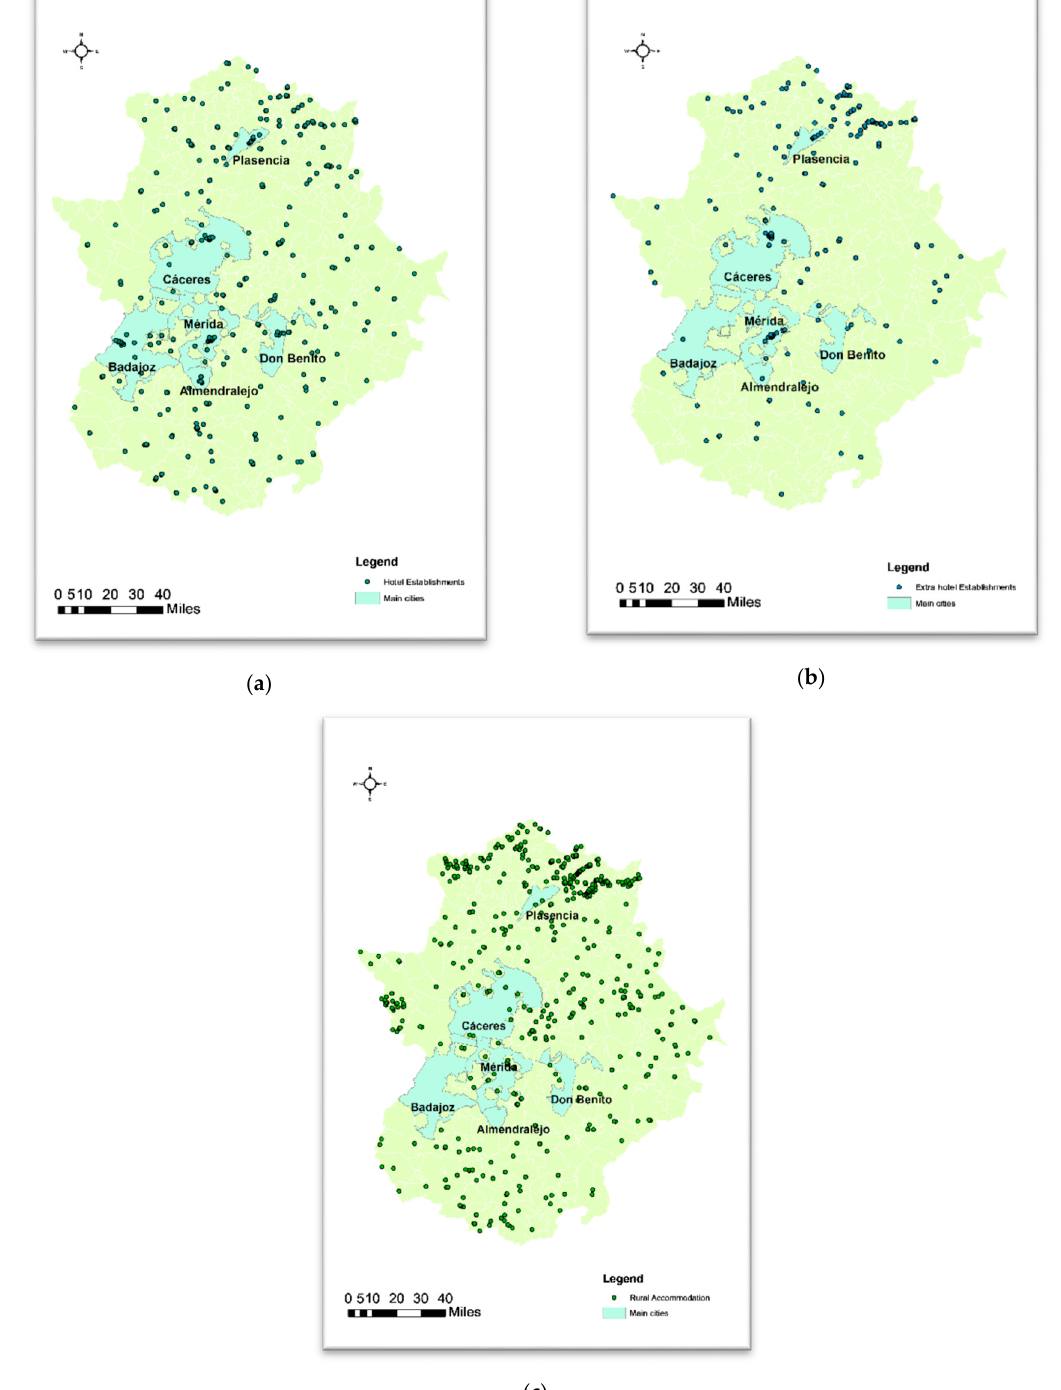
Figure 3. Spatial representation of types of accommodation establishments in Extremadura. ( a ) Hotel establishments. ( b ) Extra-hotel establishments. ( c ) Rural accommodation.